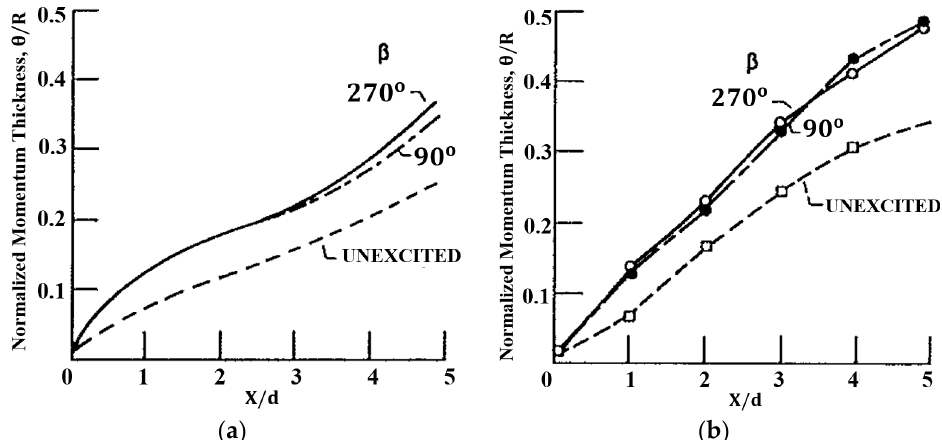
Figure 19. ( a ) Development of the momentum thickness for an excitation and unexcited case ( a )